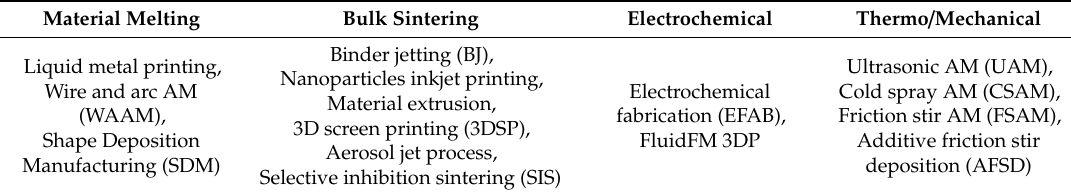
Figure 2. Growth in beamless metal-AM systems comparing with beam-based systems (column numbers indicate the number of most common commercially launched systems), data acquired from the Scopus database, and the Wohlers Report [1]. Table 1. Layer bonding mechanisms of di ff erent beamless metal AM